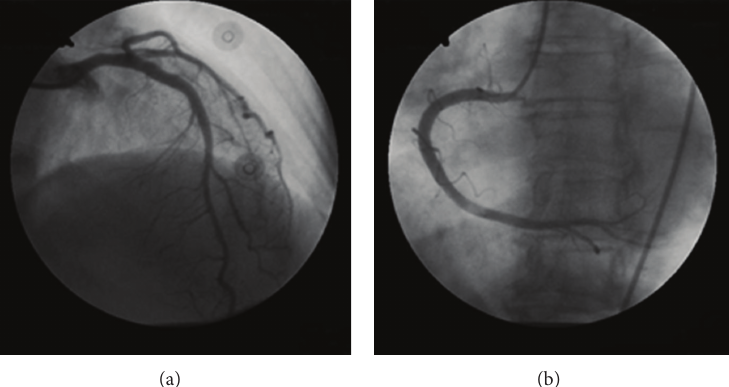
Figure 2: (a) Angiography of left coronary artery. (b) Angiography of right coronary artery. There is no obvious stenosis or obstruction in both